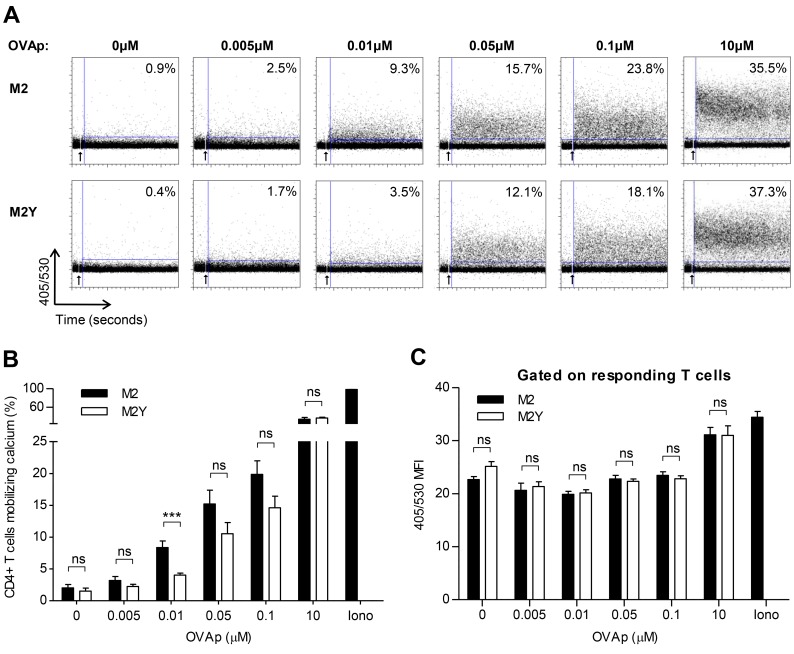
Calcium mobilization in TH cells conjugated with M2-expressing B cells requires specific peptide presentation.A20 B cells stably expressing M2 or M2Y were pulsed overnight, or not, with different concentrations of OVAp and incubated with OVAp-specific CD4+ T cells for 5 min. Prior to conjugation T cells were loaded with the calcium indicator Indo-I. Ionomycin was used as a positive control. (A) Representative FACS plots of calcium measurements. A baseline was established by acquiring unstimulated TH cells alone, for approximately two minutes. Calcium fluxes were then measured on a MoFlow cytometer for 18 minutes (indicated by an arrow) and were based on the 405/530 emission ratio over time. 405/530 mean fluorescence intensity (MFI) is shown. (B) Average of the percentage of CD4+ T cells mobilizing calcium when conjugated with M2-expressing (filled bars) or M2Y-expressing (open bars) B cells. (C) 405/530 MFI average within responding T cells. Graphs show results from three to seven experiments. Error bars represent standard error of the mean. Statistical significance of the difference between groups was evaluated by a one-tailed unpaired Student’s T test.